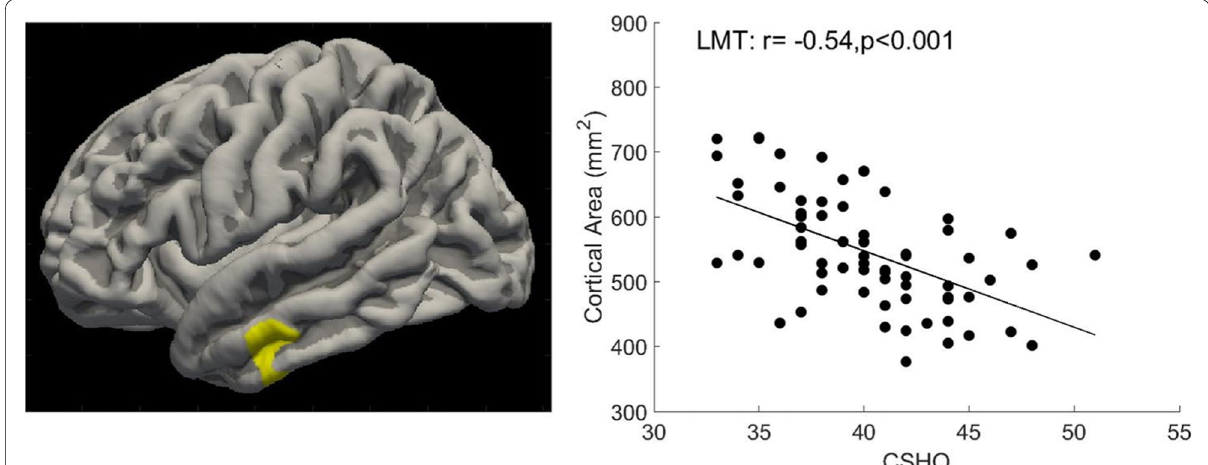
Fig. 1 The image on the left shows a cluster in the left middle temporal (LMT) gyrus with significant relationship (cluster‑wise corrected P between CSHQ total sleep disturbance score and cortical surface area, in standard MNI305 atlas. The scatter plot on the right illustrates the data of CSHQ total score vs. cortical surface area in this cluster for all subjects, and the correlation coefficient calculated by Spearman’s Partial Correlation